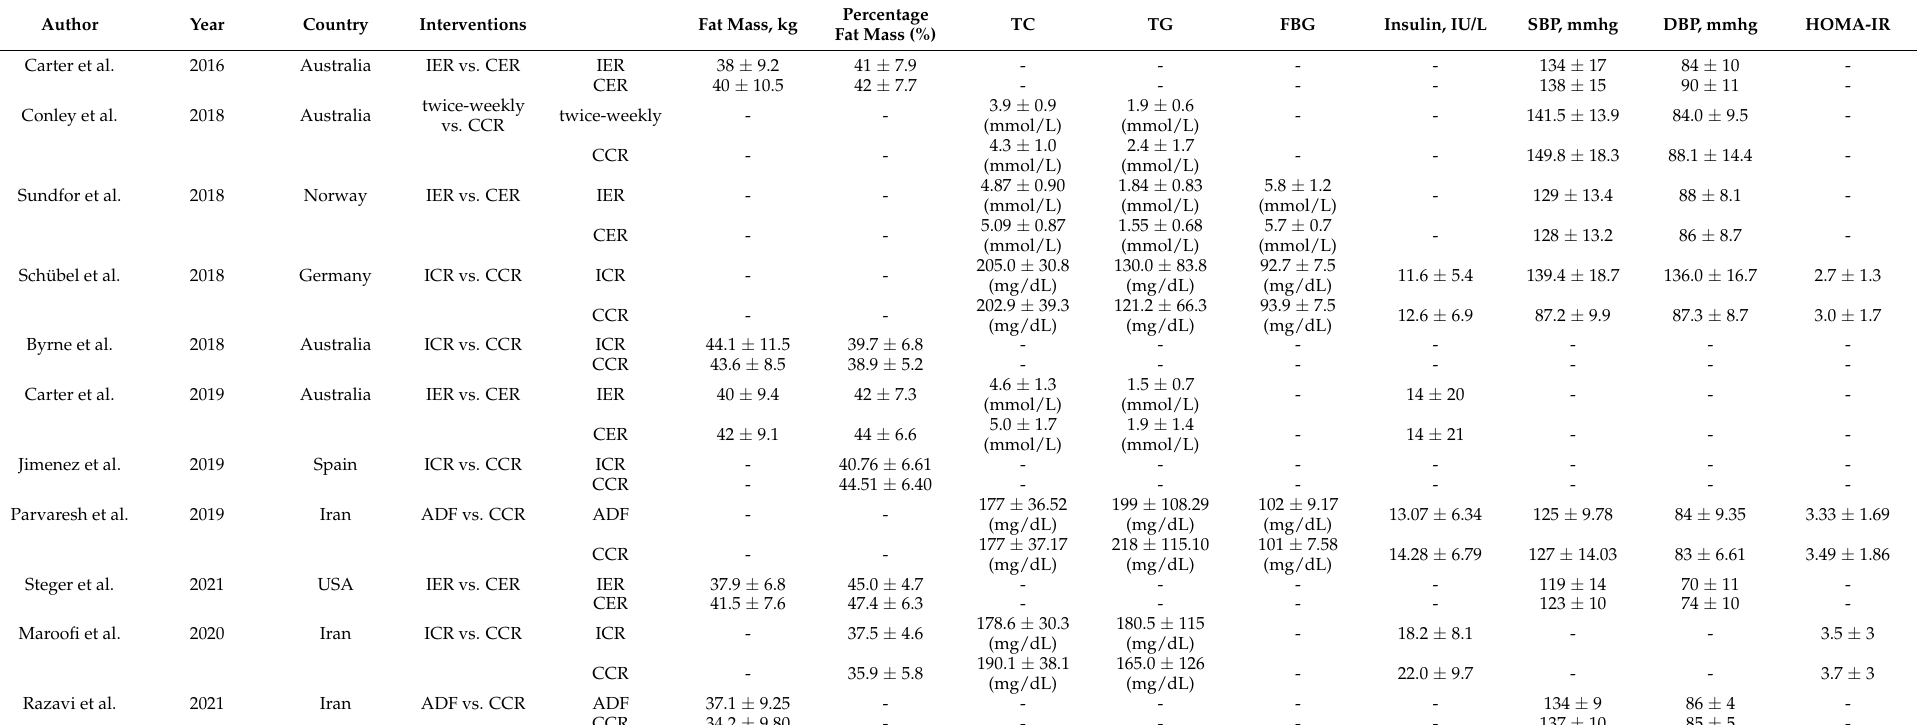
Table 2. Characteristics of included